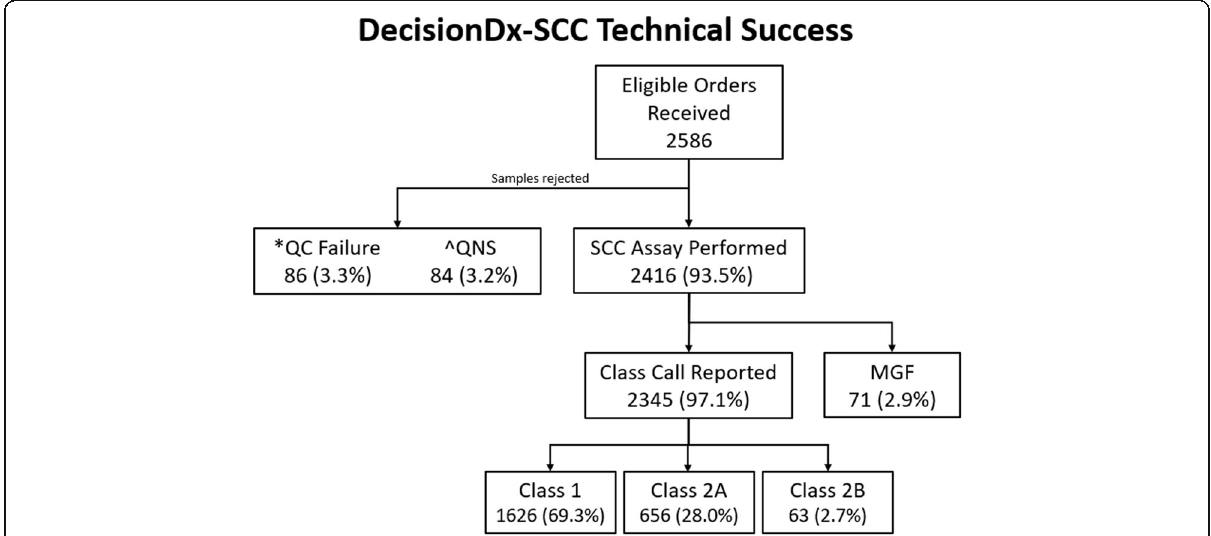
Fig. 4 Technical experience of the DecisionDx-SCC test for orders submitted from September 1, 2020 – July 31, 2021. *QC failure = quality control failure (< 40% tumor content); ^QNS = quantity not sufficient (RNA < 5.0 ng/ μ